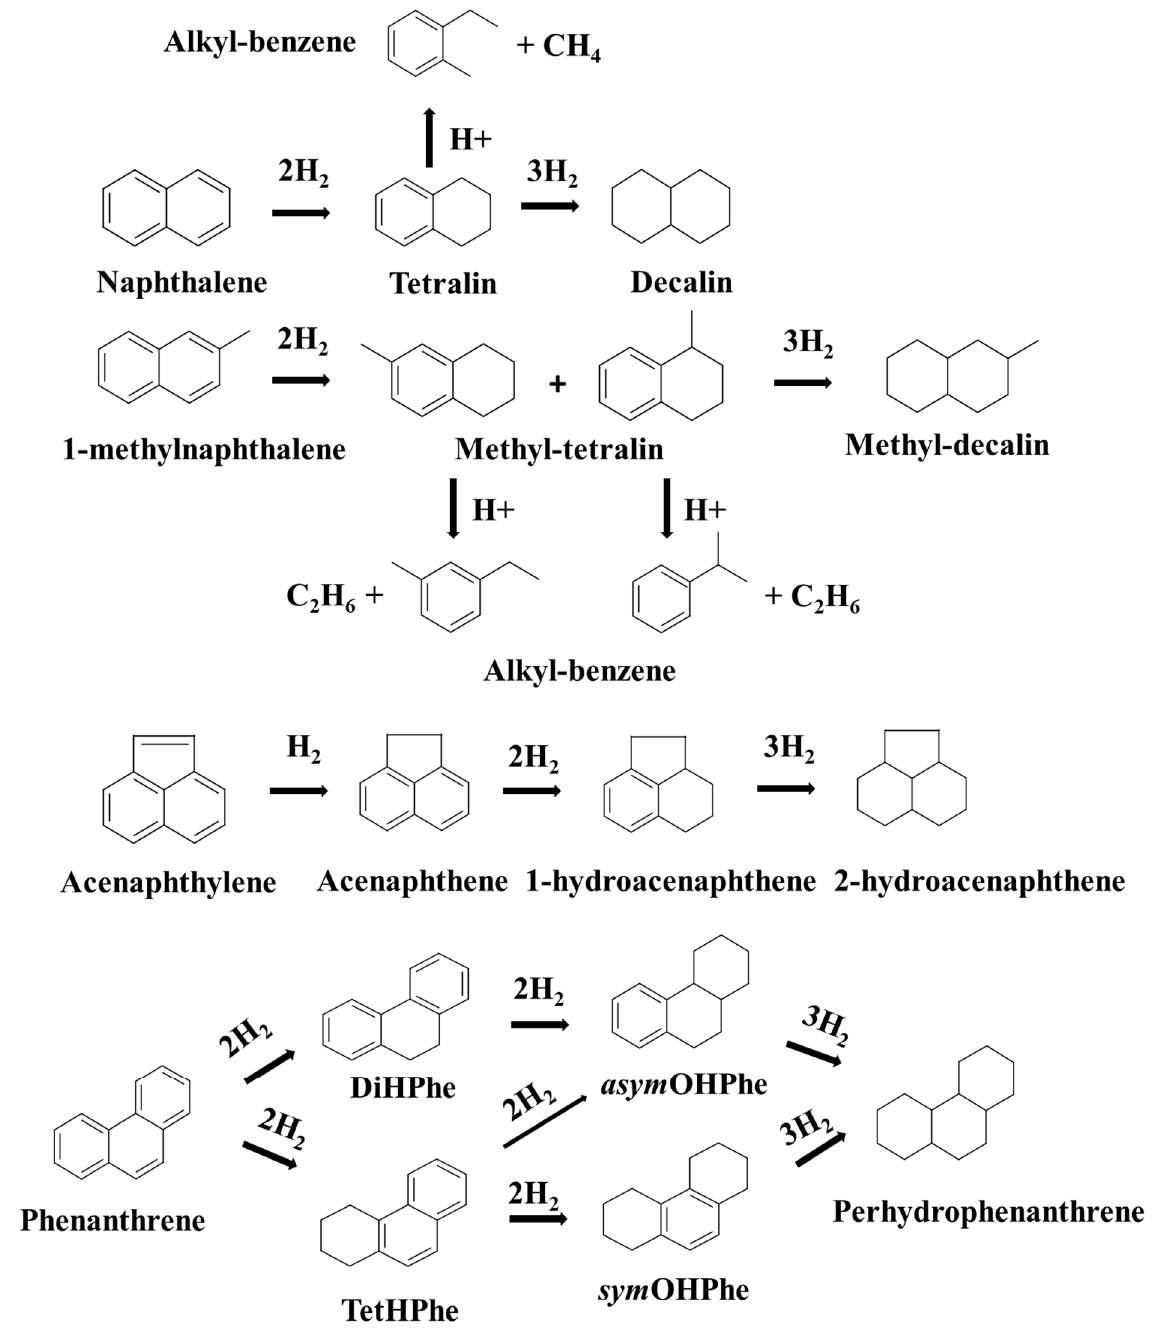
Figure 3. Proposed reaction scheme for the mild hydrotreatment of tars-type compounds.